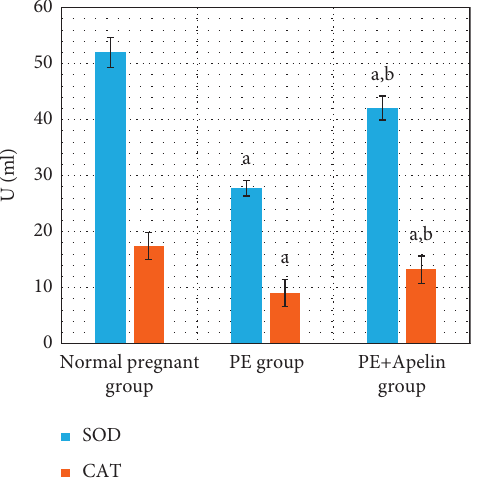
Figure 5: Serum SOD and CAT activities in all studied